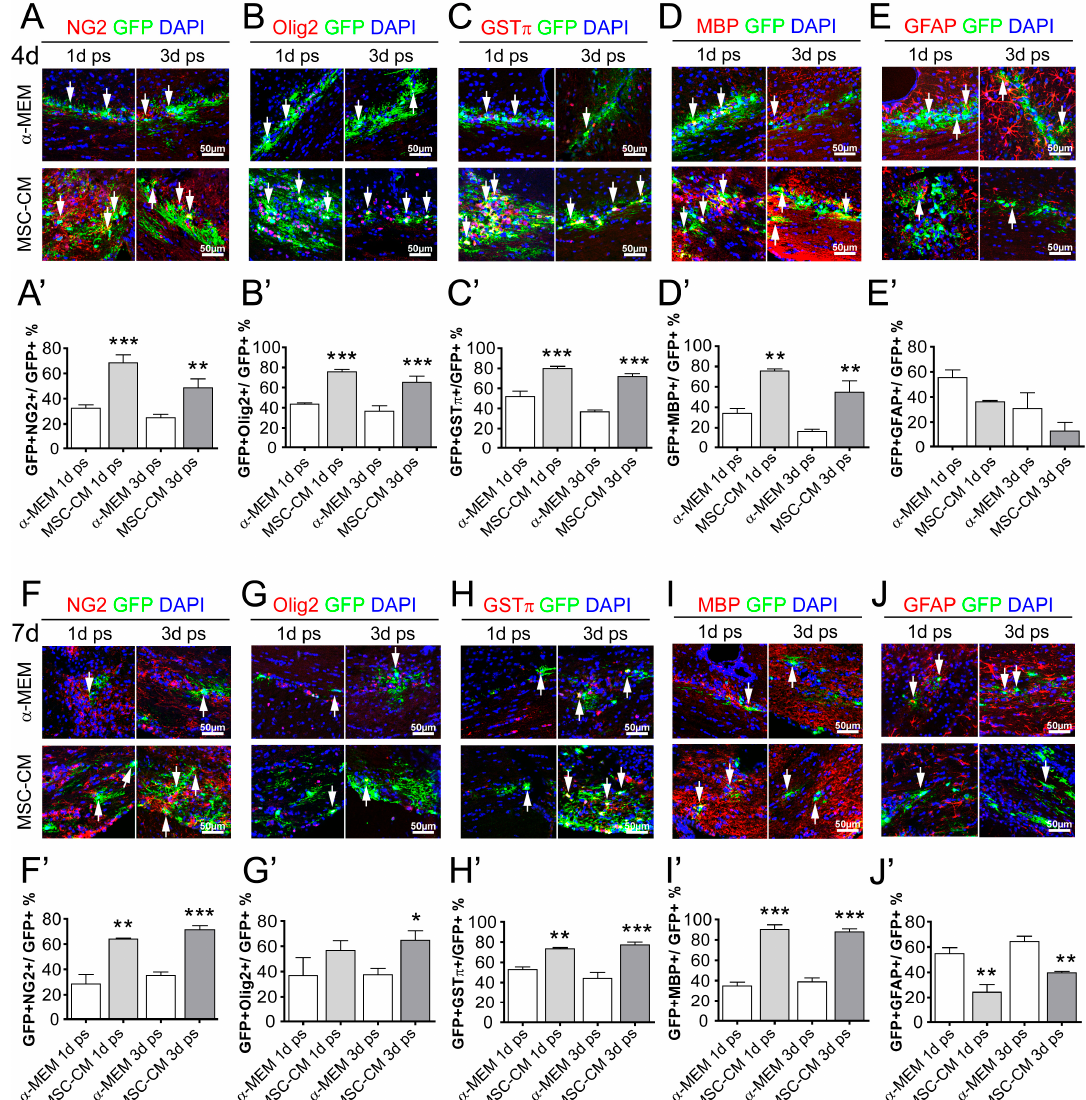
Figure 2. MSC-CM pre-stimulated aNSCs differentiated into mature myelin basic protein (MBP)-expressing oligodendrocytes after transplantation into the mouse brain. ( A-E ) Representative images of control ( α -MEM) and MSC-CM pre-stimulated and transplanted GFP-positive aNSCs expressing neural/glial antigen 2 (NG2) ( A ), oligodendrocyte transcription factor 2 (Olig2) ( B ), glutathione-S-transferase- π (GST π ) ( C ), MBP ( D ), or glial fibrillary acidic protein (GFAP) ( E ) 4 days after transplantation into the brain. Quantification of transplanted cells expressing NG2 ( A’ ), Olig2 ( B’ ), GST π ( C’ ), and MBP ( D’ ) revealed a significantly increased number of cells expressing oligodendroglial markers after 4 days, whereas the degree of GFAP-positive cells ( E’ ) was significantly decreased. The same effects were observed at 7 days post-transplantation ( F-J ) with the corresponding quantifications shown for NG2 ( F’ ), Olig2 ( G’ ), GST π ( H’ ), MBP ( I’ ), and GFAP ( J’ ). For statistical analysis, a two-way ANOVA with Bonferroni posttest was used: * p ≤ 0.05, ** p ≤ 0.01, *** p ≤ 0.001, MSC-CM compared to the respective α -MEM control (1- or 3-day pre-stimulation). Arrows point to GFP-positive cells (green) expressing the respective markers (red). Blue nuclei represent 4´,6-diamidin-2-phenylindol (DAPI) staining. Animal numbers ( n ): 3-5. 2.3. Extended Survival Time of MSC-CM Pre-Stimulated aNSCs Transplanted into the Adult Rat Spinal Cord